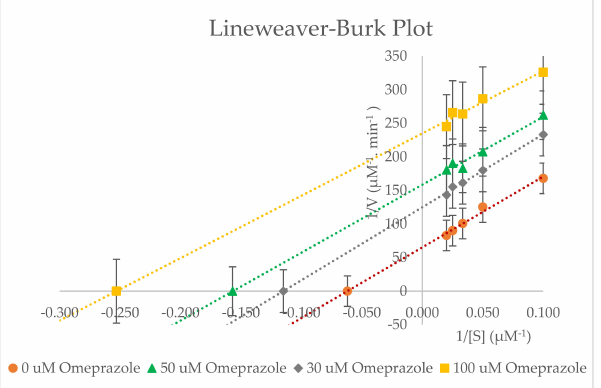
Figure 9. Lineweaver − Burk plot for the inhibition of CYP3A2 − mediated dexamethasone metabolism by various concentrations of omeprazole (0 − 100 µ M) in rat liver microsomes. Values are expressed as the average of triplicate measurements.